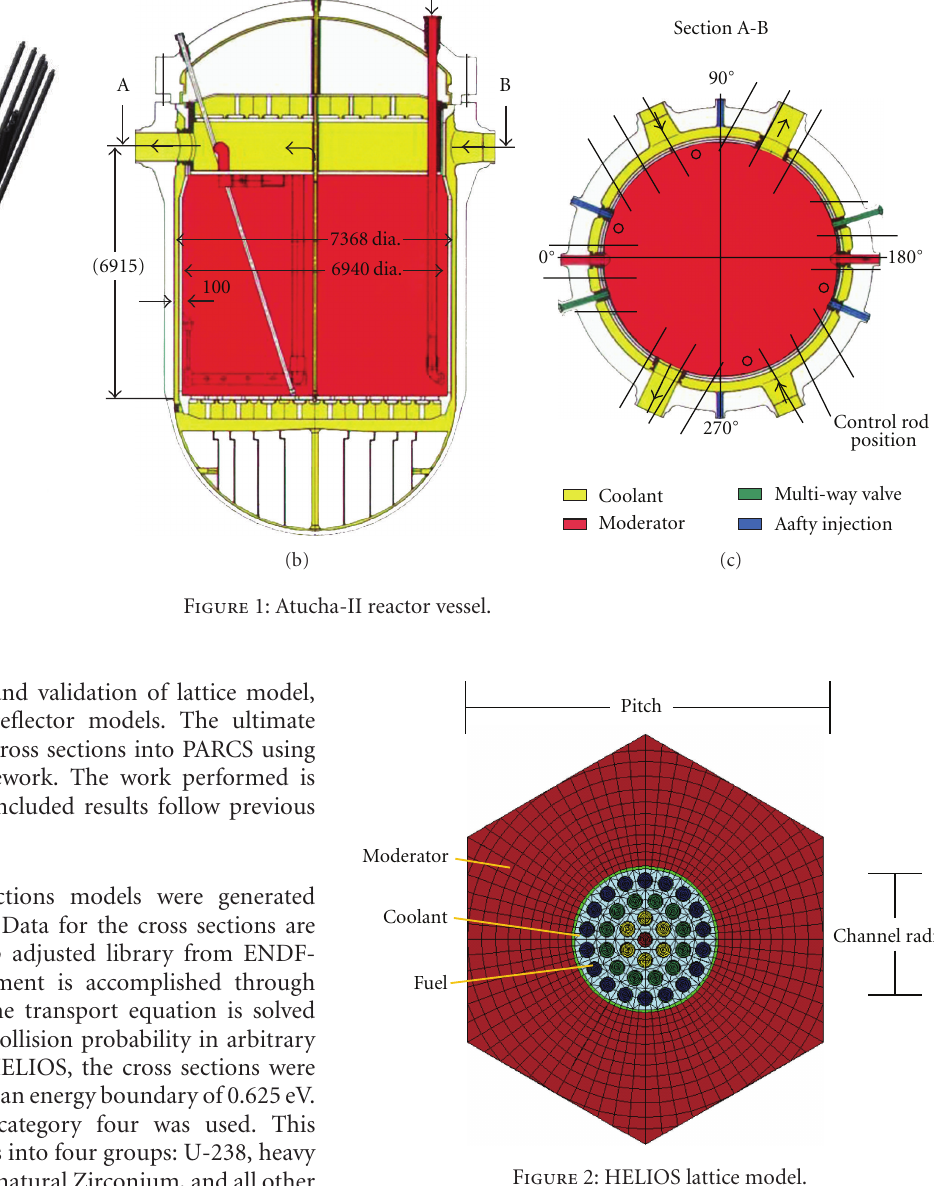
Figure 2: HELIOS lattice